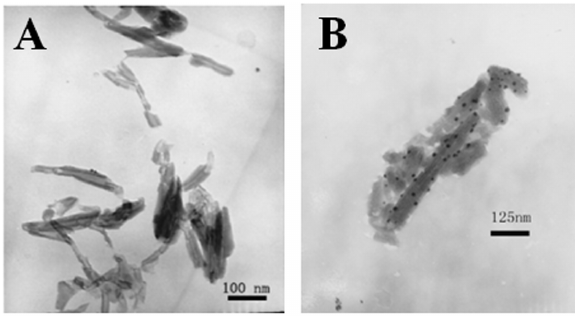
Figure 16: TEM images of HNTs (A) and Ag/HNTs (B) conducted by Liu et al.